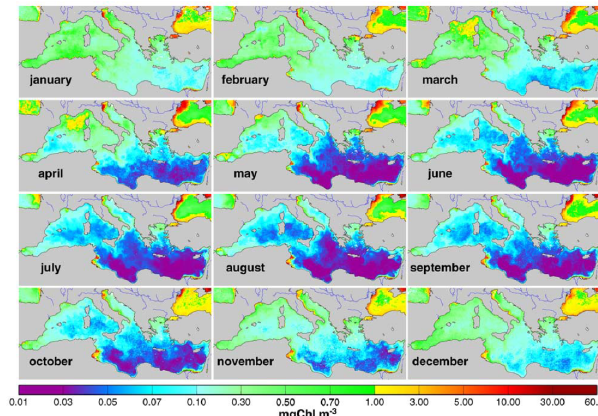
Figure 3. Monthly-averaged chlorophyll maps derived from SeaW- iFS data for the year 1999 (Bosc et al., 2004; copyright 2004 by the American Geophysical